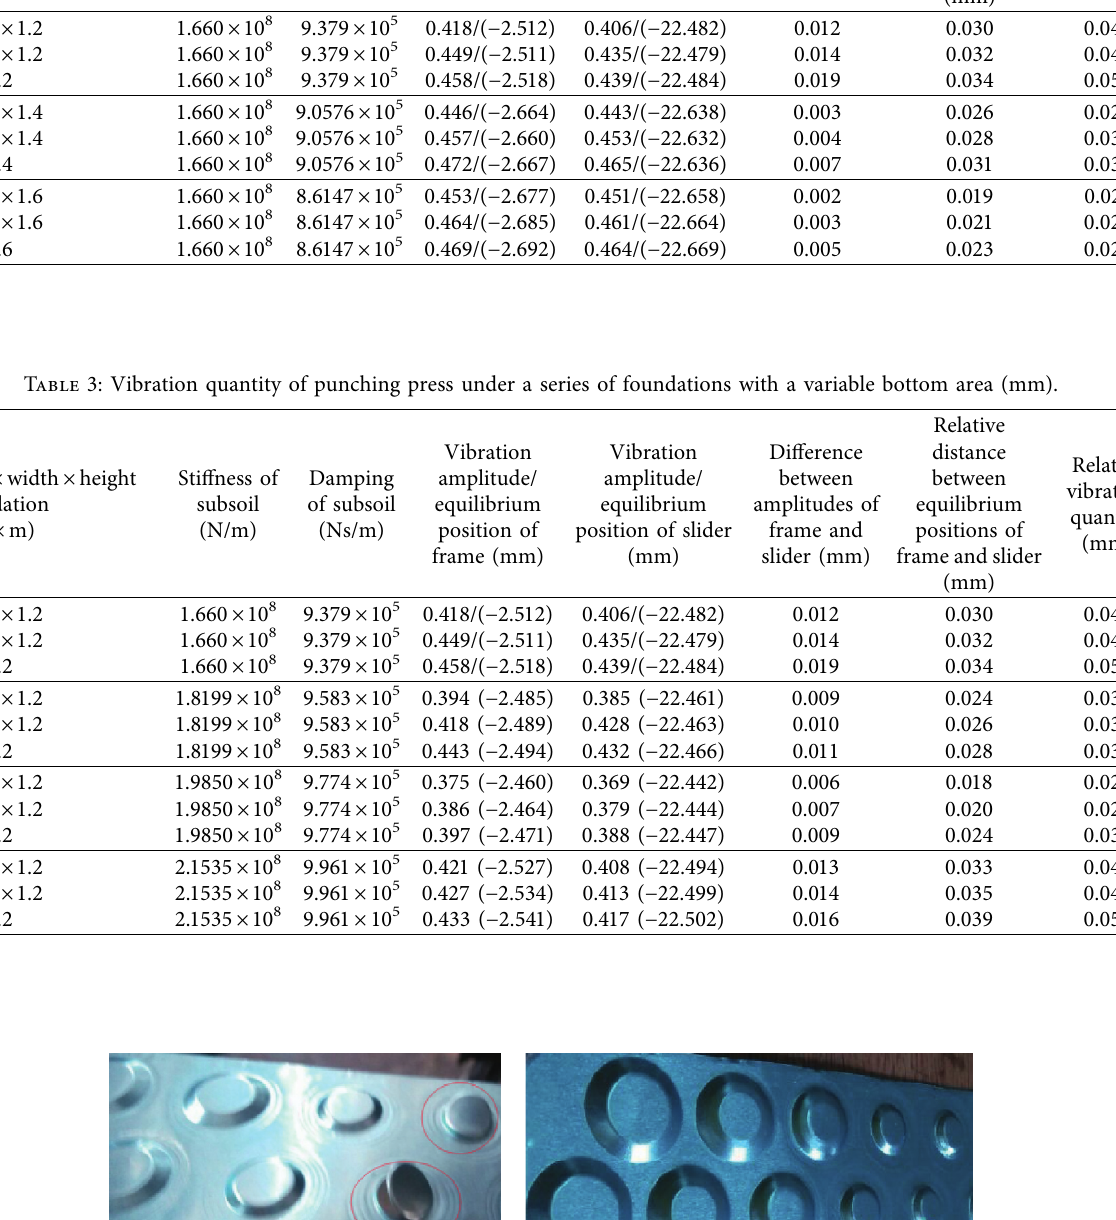
Length × width × height of foundation